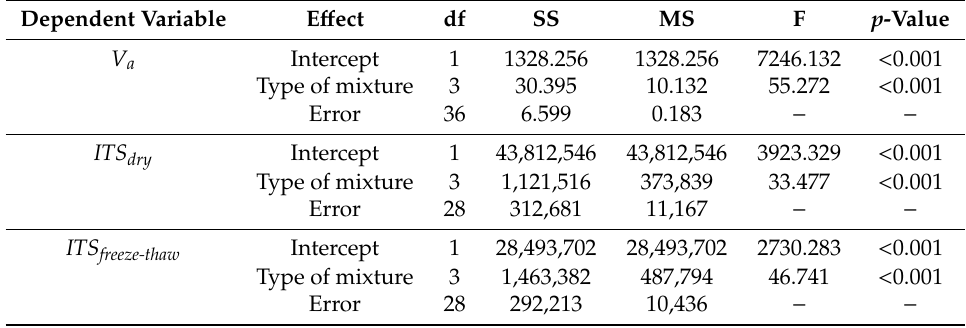
Table 14. The results of one-way ANOVA investigating significance of the type of mixture ( HMA ref ,